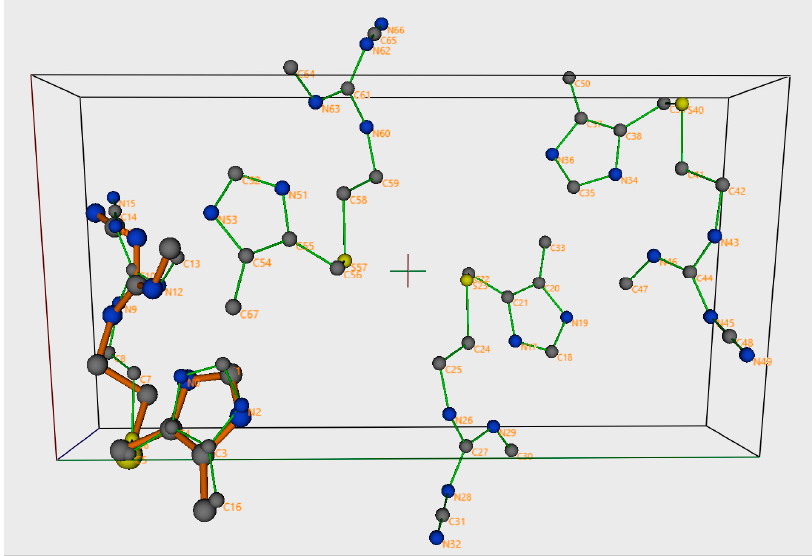
Figure 5. Successful MCSA result for cimetidine (atoms represented by small spheres and bonds in green) shown as the four crystallographically equivalent molecules in the unit cell viewed along the b-axis (a-axis vertical). The final refined structure is also shown (larger spheres and bonds in orange) for comparison. C atoms are shown in gray, N in blue, and S in yellow. Hydrogen atoms are not shown for clarity.